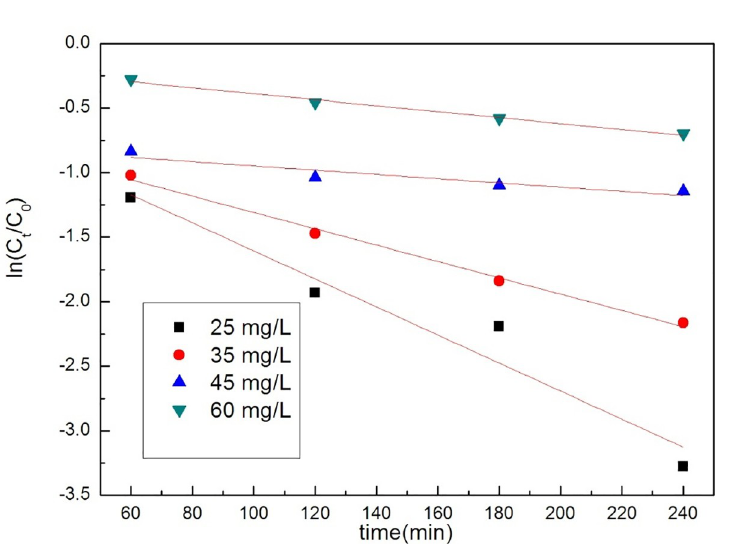
Fig 8. The Pseudo-first-order kinetic model of GO/MOFs on Orange II.